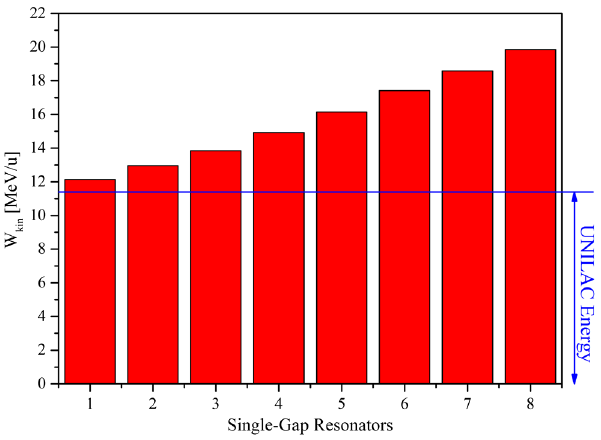
FIG. 13. UNILAC operation with eight single gap resonators for a maximum proton beam energy of 20 MeV.